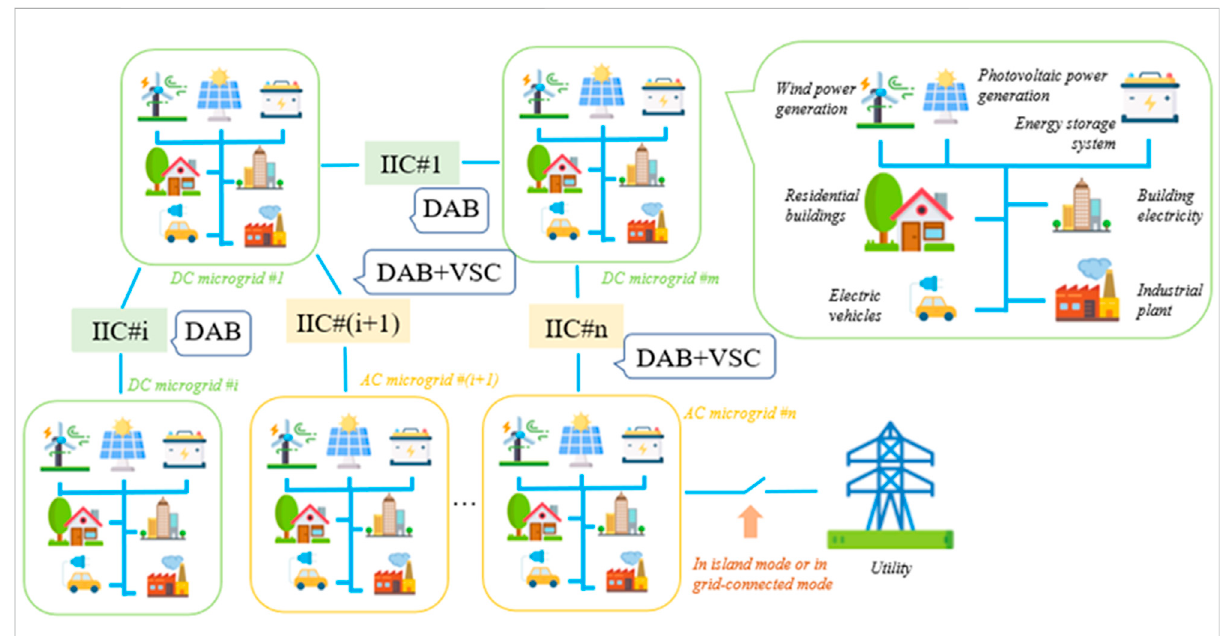
FIGURE 1 Representative hybrid DC/AC microgrids with the uni fi ed structure as the